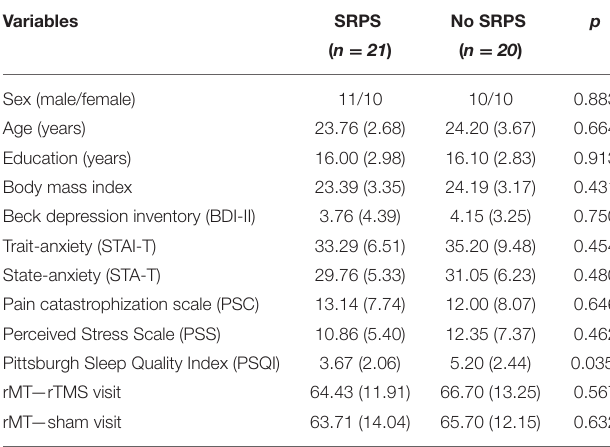
TABLE 1 | Demographic and clinical characteristics of the study sample.